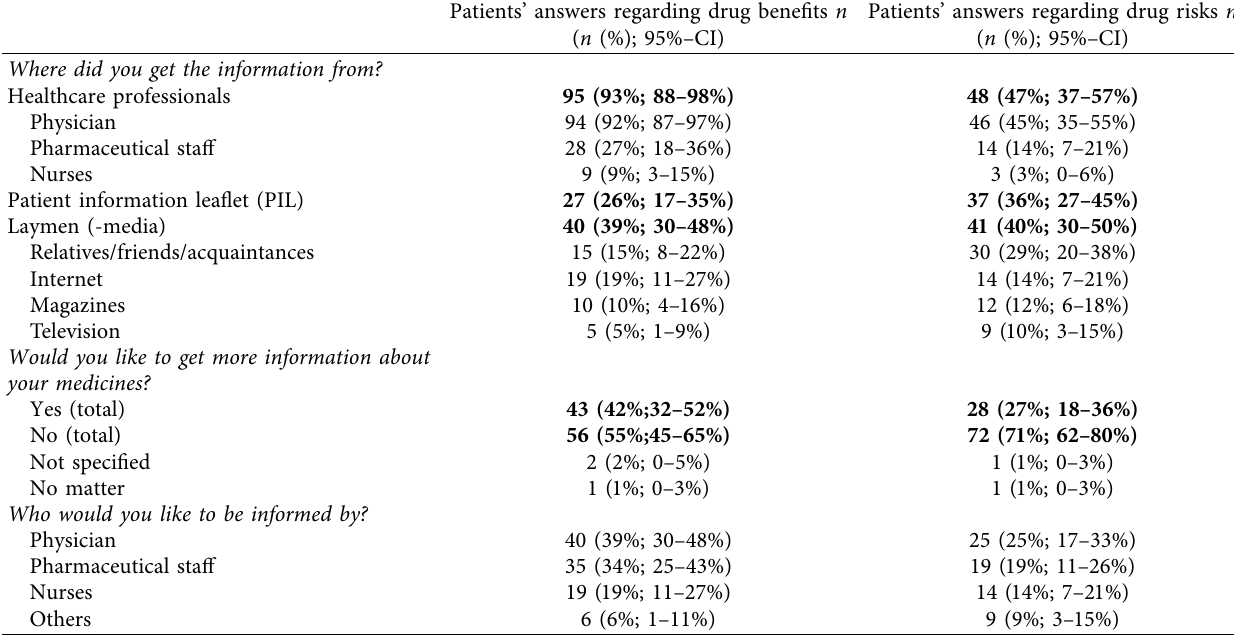
Table 4: Sources of information: number of patients who use and request certain sources of information about benefts and risks concerning their drug therapy ( n total � 102 patients). Multiple categories were